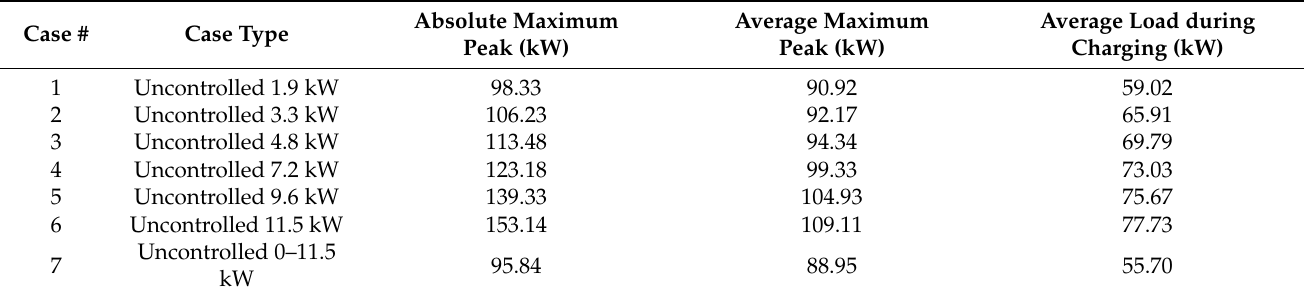
Table 4. Demand from each uncontrolled case.